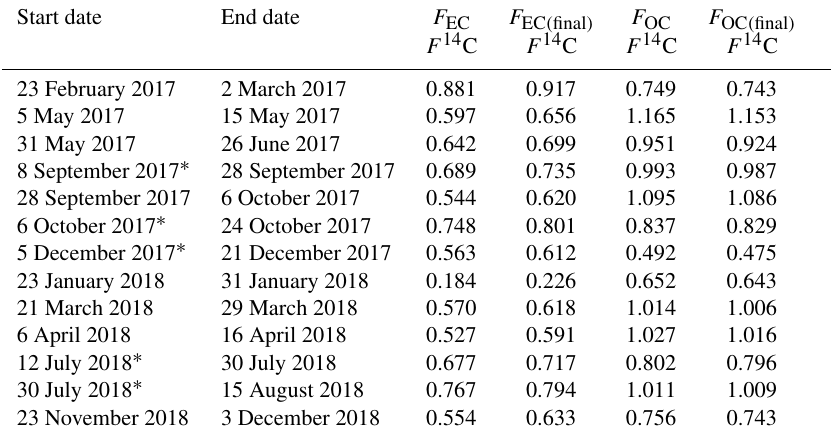
Table 4. Radiocarbon values for EC and OC before (i.e. F EC and F OC , respectively) and after the COMPYCALC extrapolation (i.e. F EC ( final ) and F OC ( final ) ,